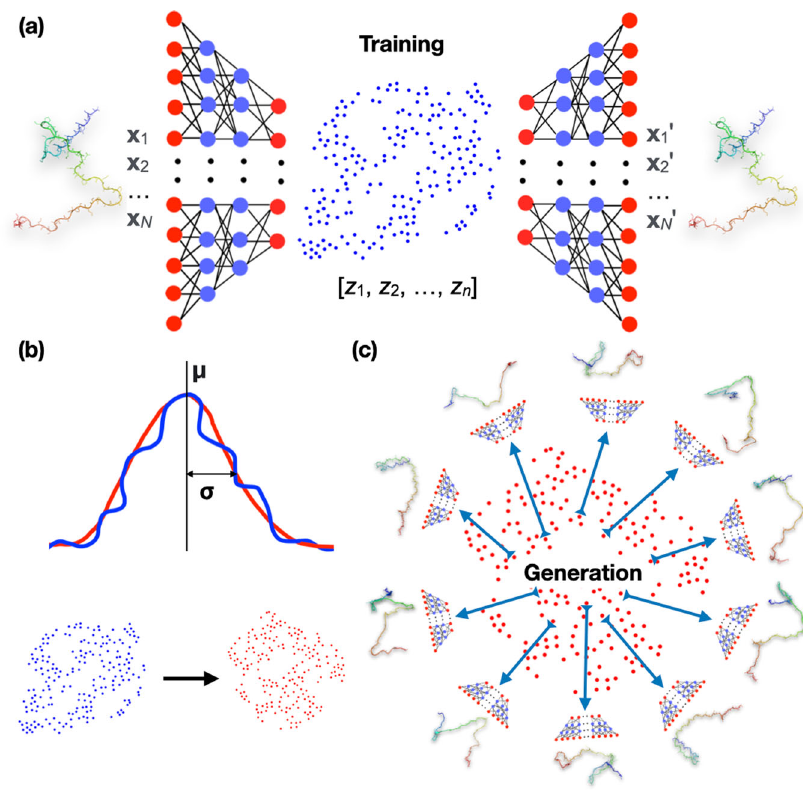
Fig. 1 Design of generative autoencoders. a Illustration of the architecture of an autoencoder. The encoder part of the autoencoder represents the conformations of an IDP, speci fi ed by the Cartesian coordinates [ x 1 , x 2 , … , x N ] of N heavy atoms, as n -dimensional vectors [ z 1 , z 2 , … , z n ] in the latent space. The decoder then reconstructs the latent vectors back to conformations in Cartesian coordinates, [ x 1 ′ , x 2 ′ , … , x N ′ ]. During training, the weights of the neural networks are tuned to minimize the deviation of the reconstructed conformations from the original ones. b Modeling of the distribution of the latent vectors (blue) of the training set by a multivariate Gaussian (red). The mean vector and covariance matrix of the Gaussian are those of the training latent vectors. The curves illustrate a Gaussian fi t to the distribution of the training data; the scatter plots show a comparison of the training data and the Gaussian model. c Generation of new conformations. Vectors sampled from the multivariate Gaussian are fed to the decoder to generate new conformations. IDP structures are shown in a color spectrum with blue at the N-terminus and red at the